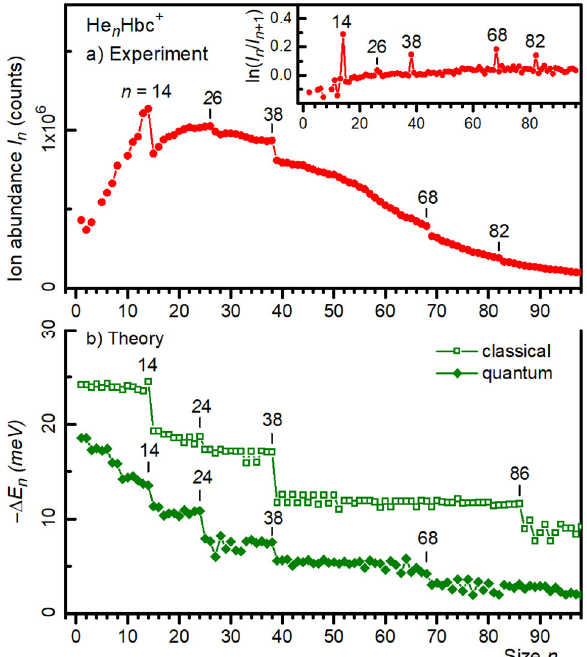
Figure 2. ( a ) Ion abundance I n of He n Hbc + cations versus size n . The insert displays the negative first derivative of the logarithmic ion abundance. ( b ) The first derivative of the energy − E n of He n Hbc + calculated from the classical global minima and the quantum virial energy (open squares and filled diamonds, respectively).